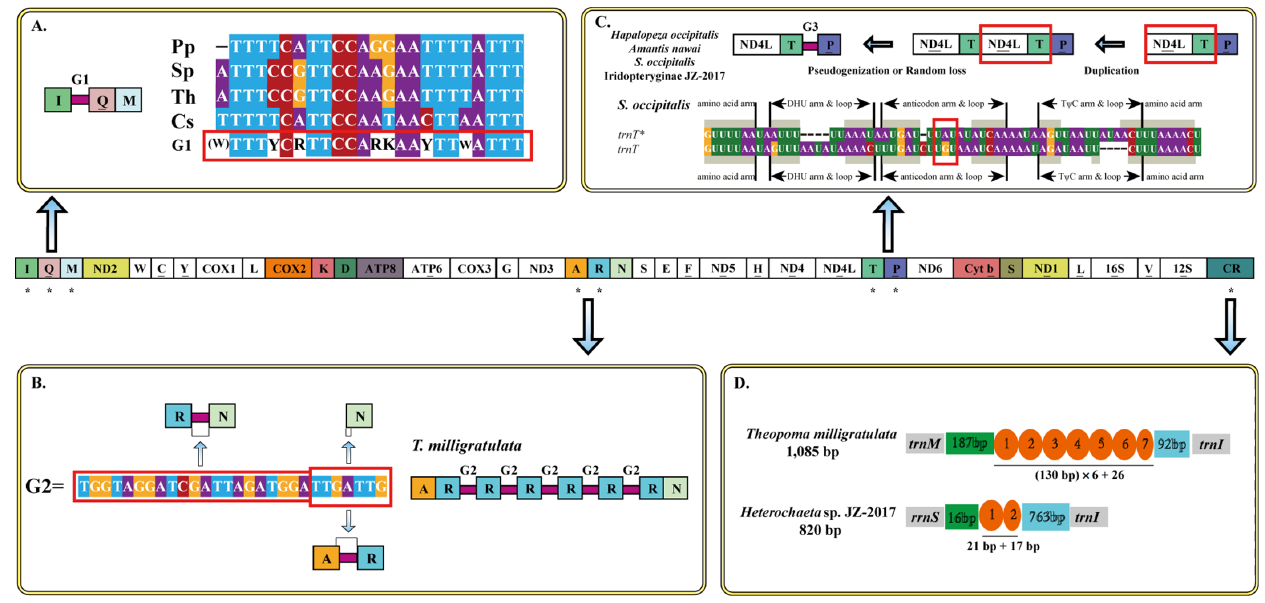
Figure 3. Intergenic gaps are introduced by gene rearrangement and duplication. The gene and genome sizes are not to scale. The majority strand encodes all genes with white blocks, and the minority strand encodes all genes with different colored blocks. The asterisks (*) indicate the gene regions to be displayed and discussed. ( A ) G1 introduced by gene rearrangement in four Toxoderidae mitogenomes. Pp: Paratoxodera polyacantha . Sp: Stenotoxodera porioni . Th: Toxodera hauseri . Cs: Cheddikulama straminea . ( B ) G2 introduced by gene duplication in Gonypetidae mitogenomes. ( C ) G3 introduced by gene pseudogenization or random loss in Iridopterygidae. ( D ) Tandem repeats (TDRs) of CRs in T. milligratulata and Heterochaeta sp. JZ-2017.